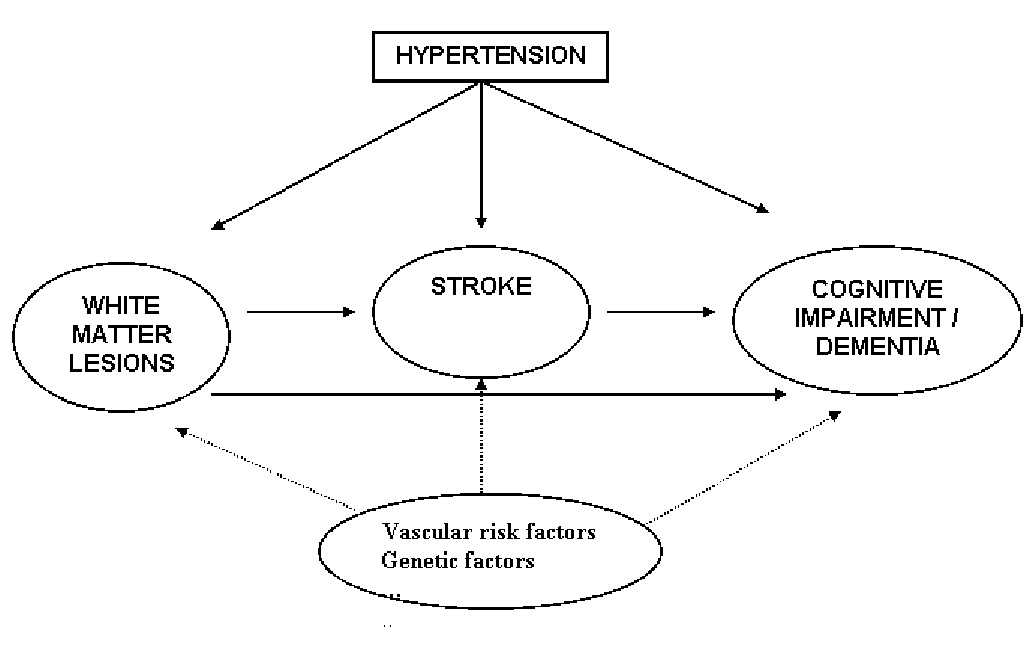
FIGURE 1 . Different connections among hypertension, WML, and cognitive